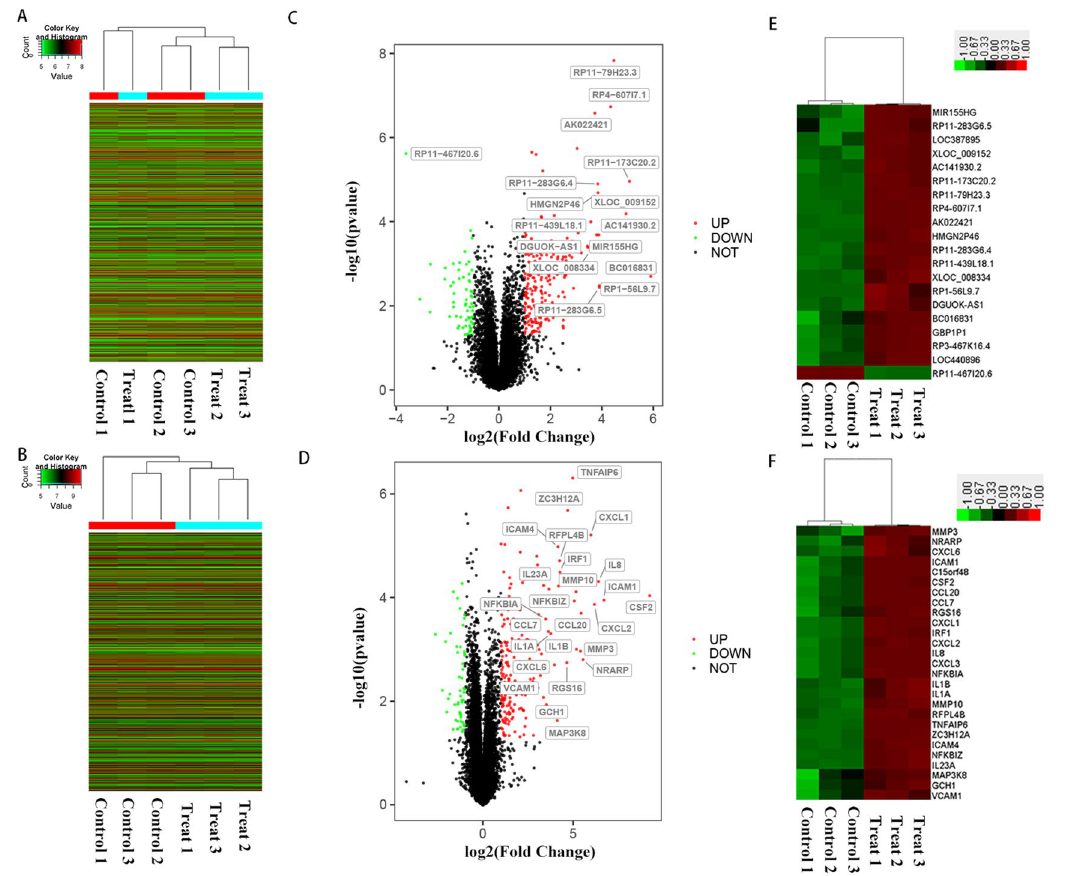
Figure 1. Volcano plots and heatmaps of changes in lncRNA and mRNA expression profiles in SFMSCs after IL-1β stimulation for 2 h. ( A , B ) Heatmap of differentially expressed lncRNAs ( A ) and mRNAs ( B ) showing a fold change > 1 in SFMSCs before and after IL-1β stimulation. ( C , D ) Volcano plots of lncRNA expression levels ( C ) and mRNA expression levels ( D ) before and after IL-1β stimulation. The red dots represent lncRNAs or mRNAs showing ≥ twofold upregulation, and the green dots represent downregulation ( P < 0.05). Dots labeled with Seqname represent lncRNAs or mRNAs showing ≥ tenfold. ( E , F ) Heatmap of differentially expressed lncRNAs ( E ) and mRNAs ( F ) showing a fold changes ≥ 10 and P < 0.05 in SFMSCs before and after IL-1β stimulation. Genesymbol was used to label the genes. Volcano plots was performed using R Software created by R Core Team (2021). R: A language and environment for statistical computing. R Foundation for Statistical Computing, Vienna, Austria. https:// www.R- proje ct. org/. Heatmaps was performed using Gene Cluster 3.0